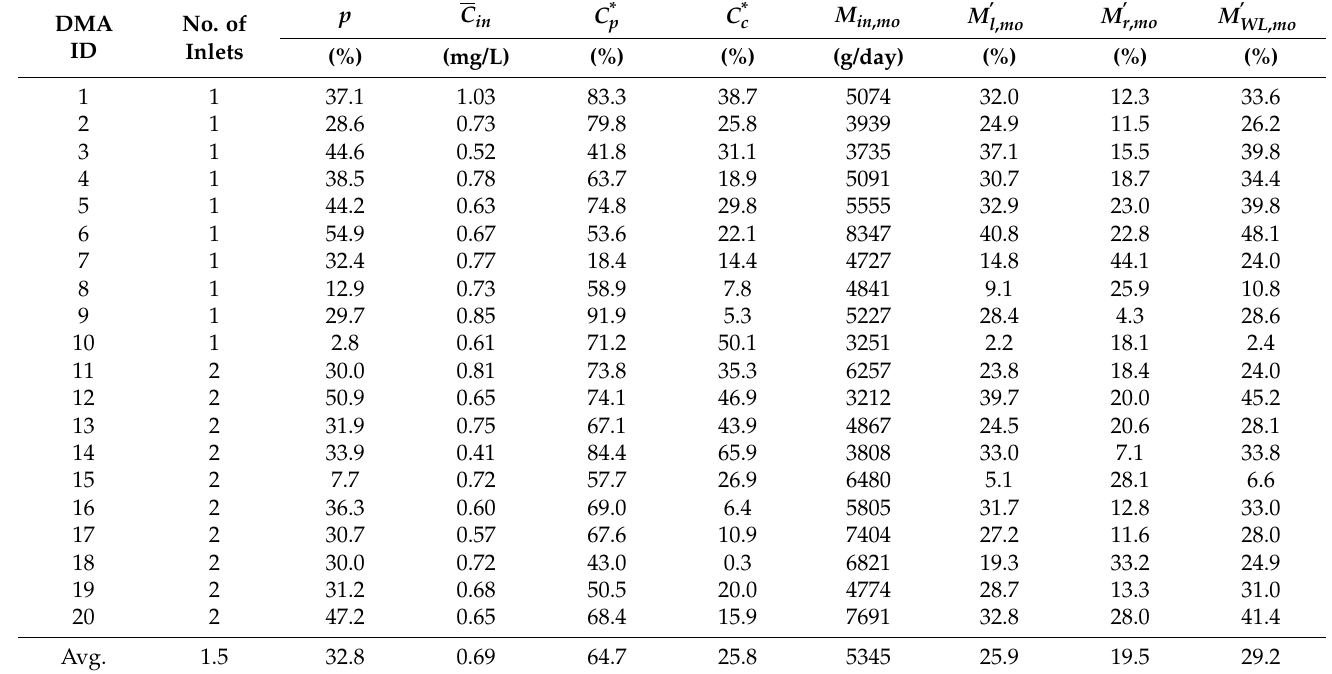
Table 1. Characteristics of DMAs and residual chlorine results from network model